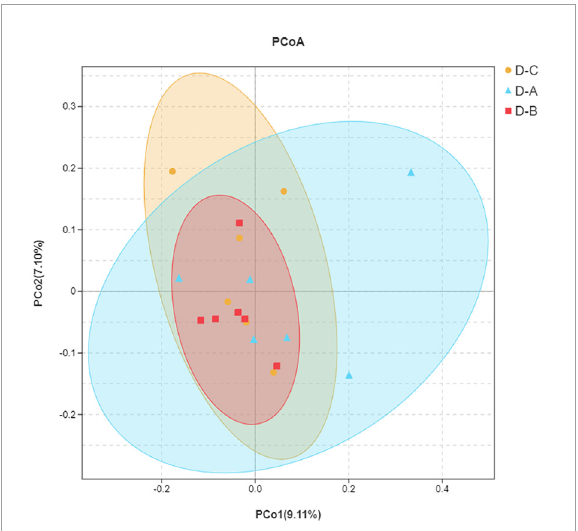
FIGURE2 Principal coordinate analysis (PCoA) plot. The closer distance between the sample points indicates a higher similarity between the